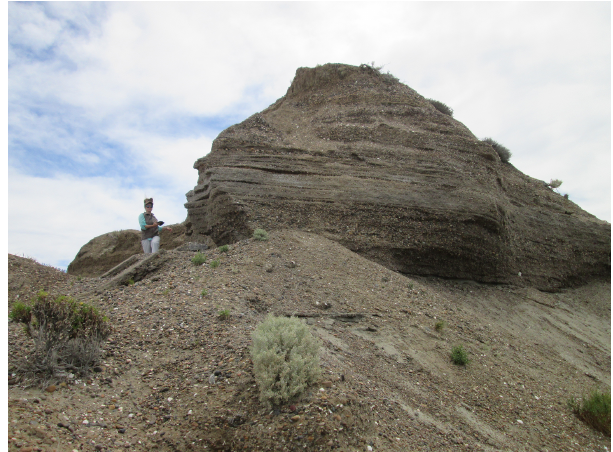
Figure 3. MIS 5 beach deposit near Caleta Olivia. The photo was taken on the front side of the beach deposit.